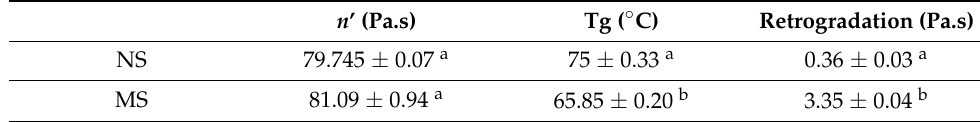
Table 4. Viscosity characteristics of native and modified extrusion rice starch.